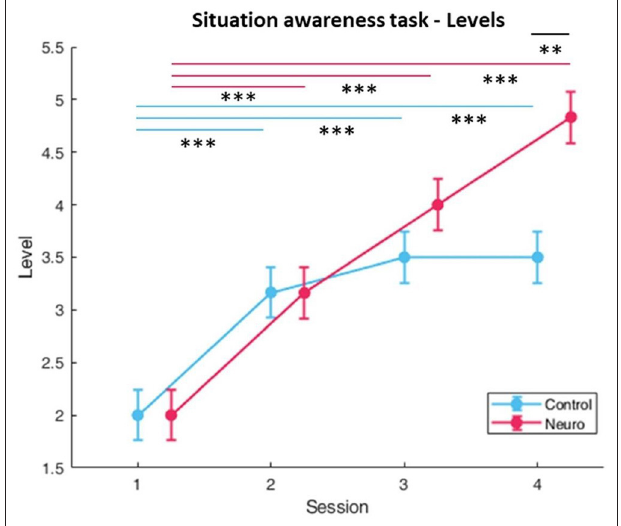
FIGURE 6 | Behavioral performance (error) as measured by flight stability, the root mean square difference between actual and ideal flight path for Landing Task. Lower values indicate better performance. Significant condition by level interaction was found (whiskers are SEM).